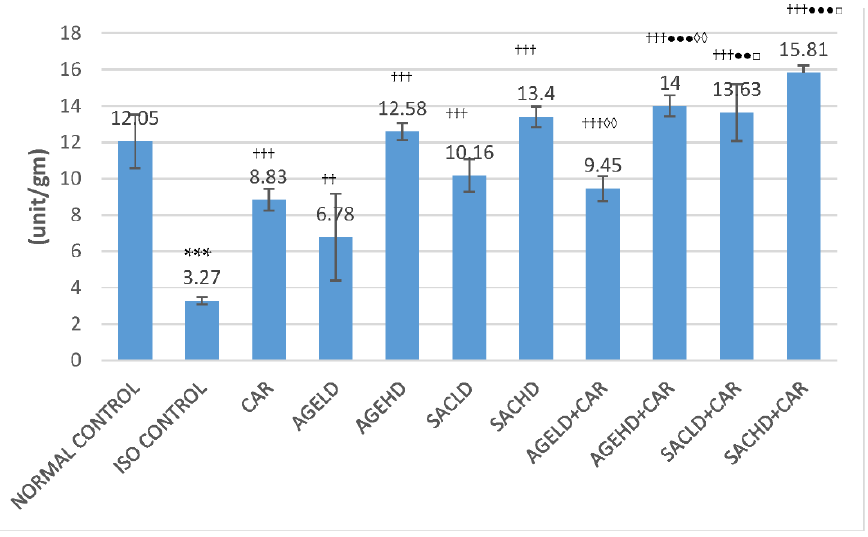
Figure 3. Effect on LDH activities in heart tissue homogenate. The data are presented as mean ± SEM; *** p < 0.001 compared with normal control; †† p < 0.01, ††† p < 0.001 in comparison with ISO control; ●● p < 0.01, ●●● p < 0.001 in comparison with carvedilol; ◊◊ p < 0.01 when compared with re ‐ spective AGE dose; □ p < 0.05 when compared with respective SAC dose.